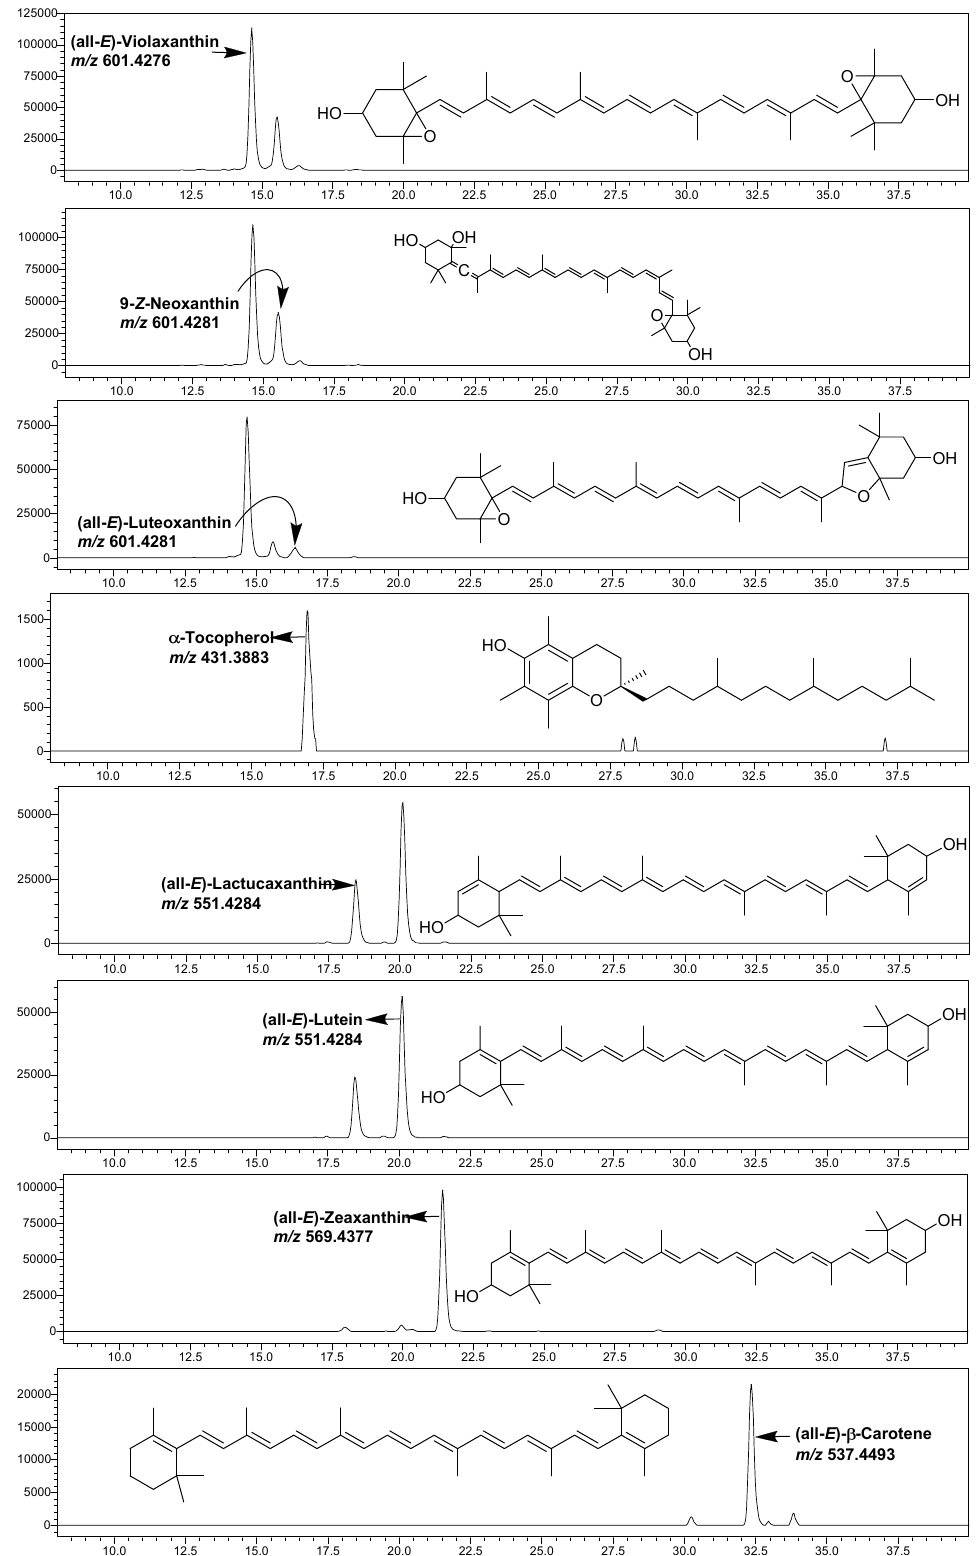
Figure 1. The representative LC-SIM-MS chromatograms of various carotenoids and α -tocopherol identified in studied GLVs.